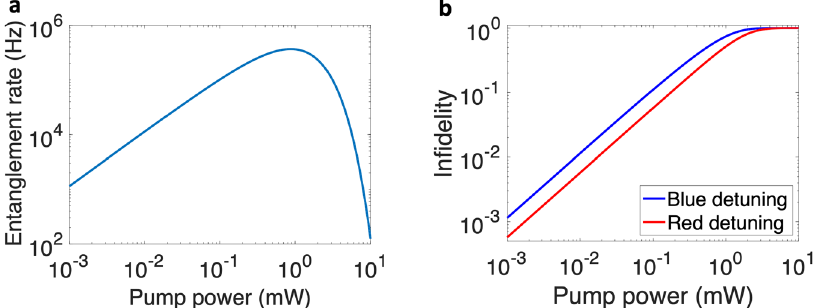
Fig. 6 Optically heralded entanglement generation based on electro-optic quantum transducers. a , b Entanglement generation rate ( a ) and in fi delity ( b ) as a function of pump power. Microwave reset time t r = 1 μ s. Duration time Δ t = 1 μ